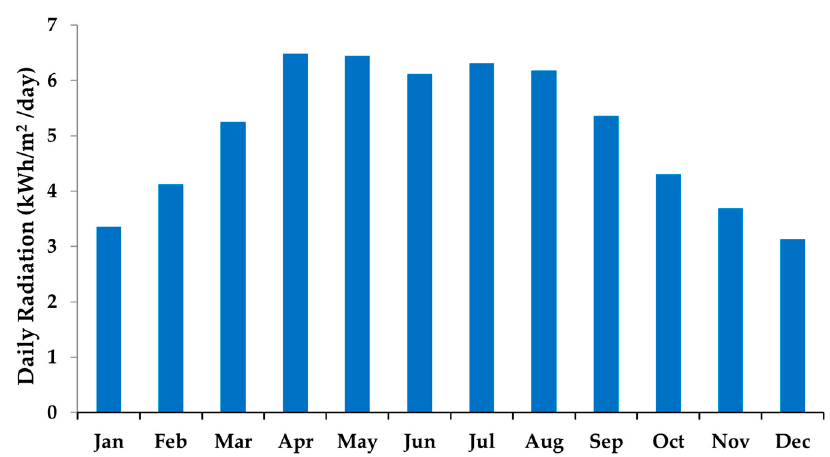
Figure 2. Annual cycle of monthly solar irradiance in San Diego.